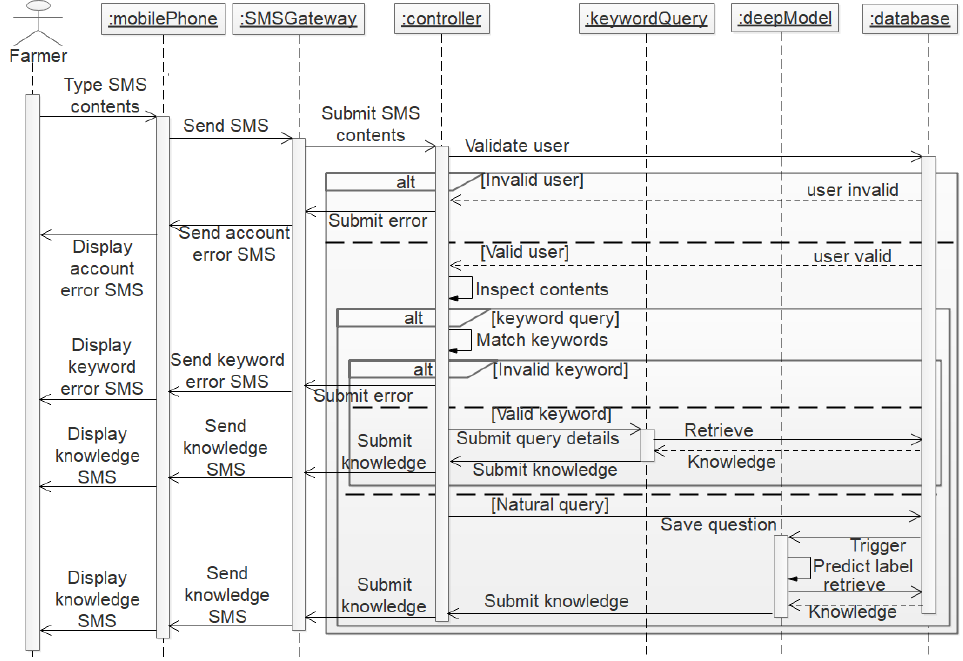
Figure 2. Sequence diagram of requesting crop protection information “knowledge” by SMS.